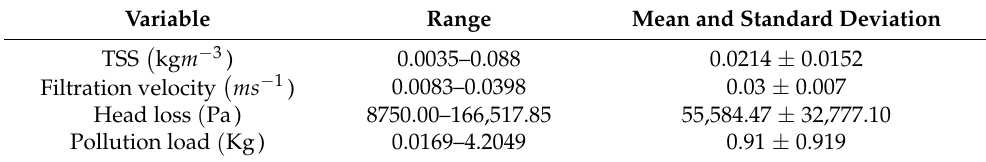
Table 2. Range of variables during testing.